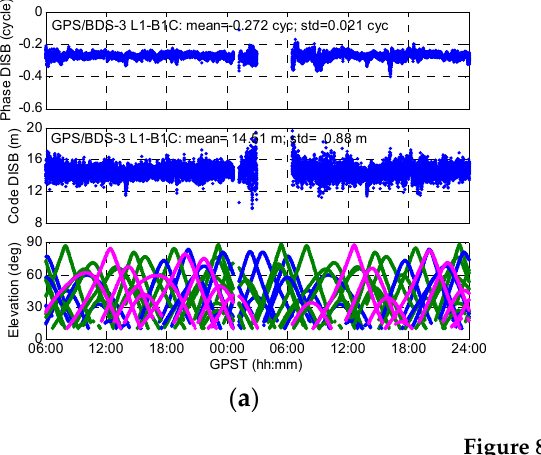
Figure 7. Estimated ISBs between GPS/BDS-3 L1-B1C ( a ), L5-B2a ( b ), and Galileo/BDS-3 E1-B1C ( c ), E5a-B2a ( d ) for short baseline based on identical receiver type (iGMAS). Figure 8 shows the estimated phase and code ISBs with different receiver types (iGMAS and M300Pro receivers) for L1-B1C/L5-B2a and E1-B1C/E5a-B2a signals, respectively. We observe that the ISB series are indeed present with non-zero values but stable in the time domain. Compared with the above identical receiver case, the STDs for the phase and code ISBs are slightly larger than that in Figure 7. For GPS/BDS-3 L1-B1C / L5-B2a signals, the average phase and code ISBs are − 0.272/0.500 cycles and 14.51/ − 90.28 m, respectively, while for Galileo/BDS-3 E1-B1C/E5a-B2a signals, the values are − 0.252/0 cycles and − 0.17/ − 89.65 m, respectively. Such results allow for calibrating and correcting